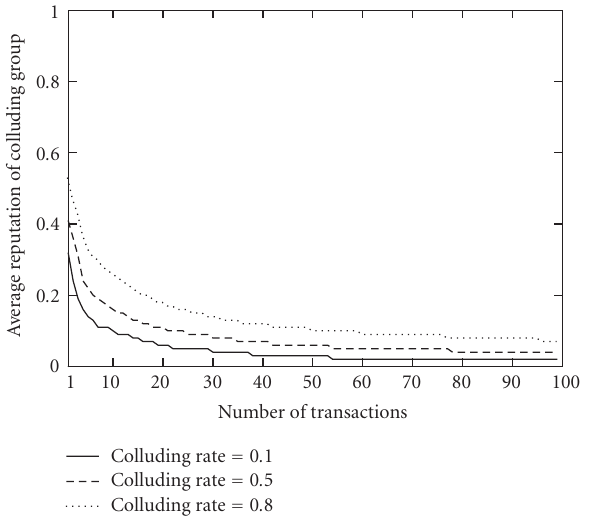
Figure 6: E ff ectiveness of our decoupled trust model against collu- sion.